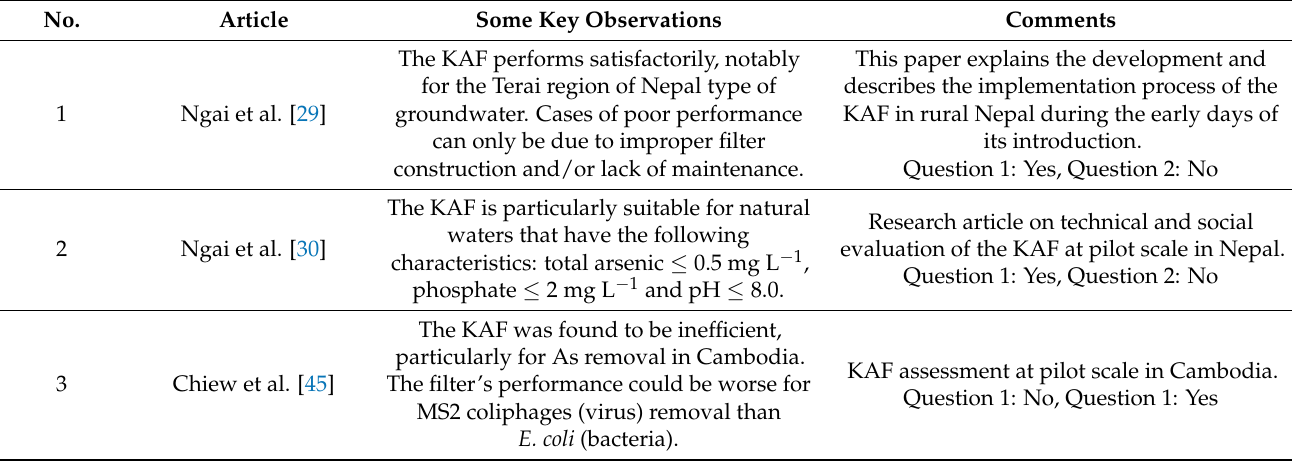
Table 3. Overview of the papers reporting on KAF, excluding our own contribution [47], with particular attention to their answers with regard to questions 1 & 2. ‘N ◦ ’ is the identification number of each article, as used later in this